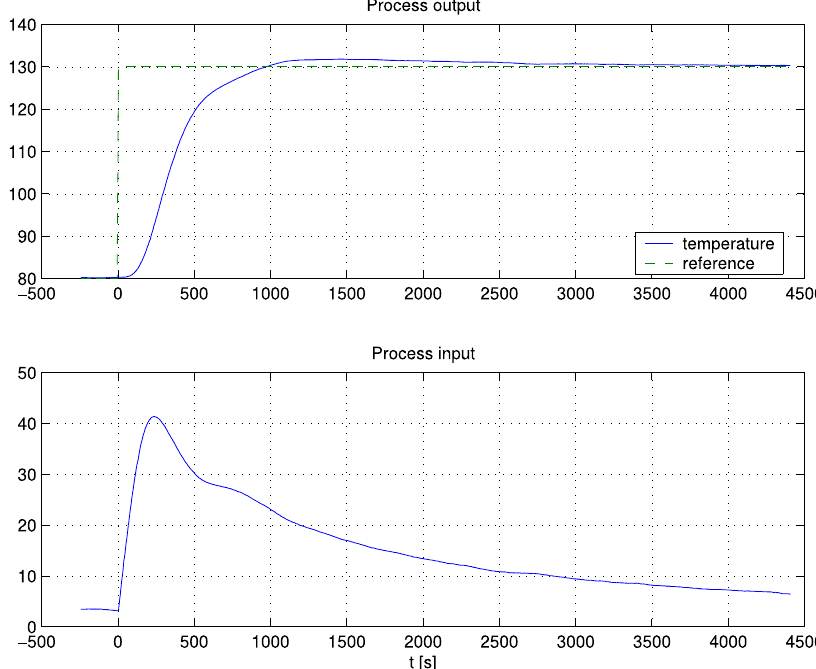
Figure 25. Process input and output signals during closed-loop autoclave experiment.